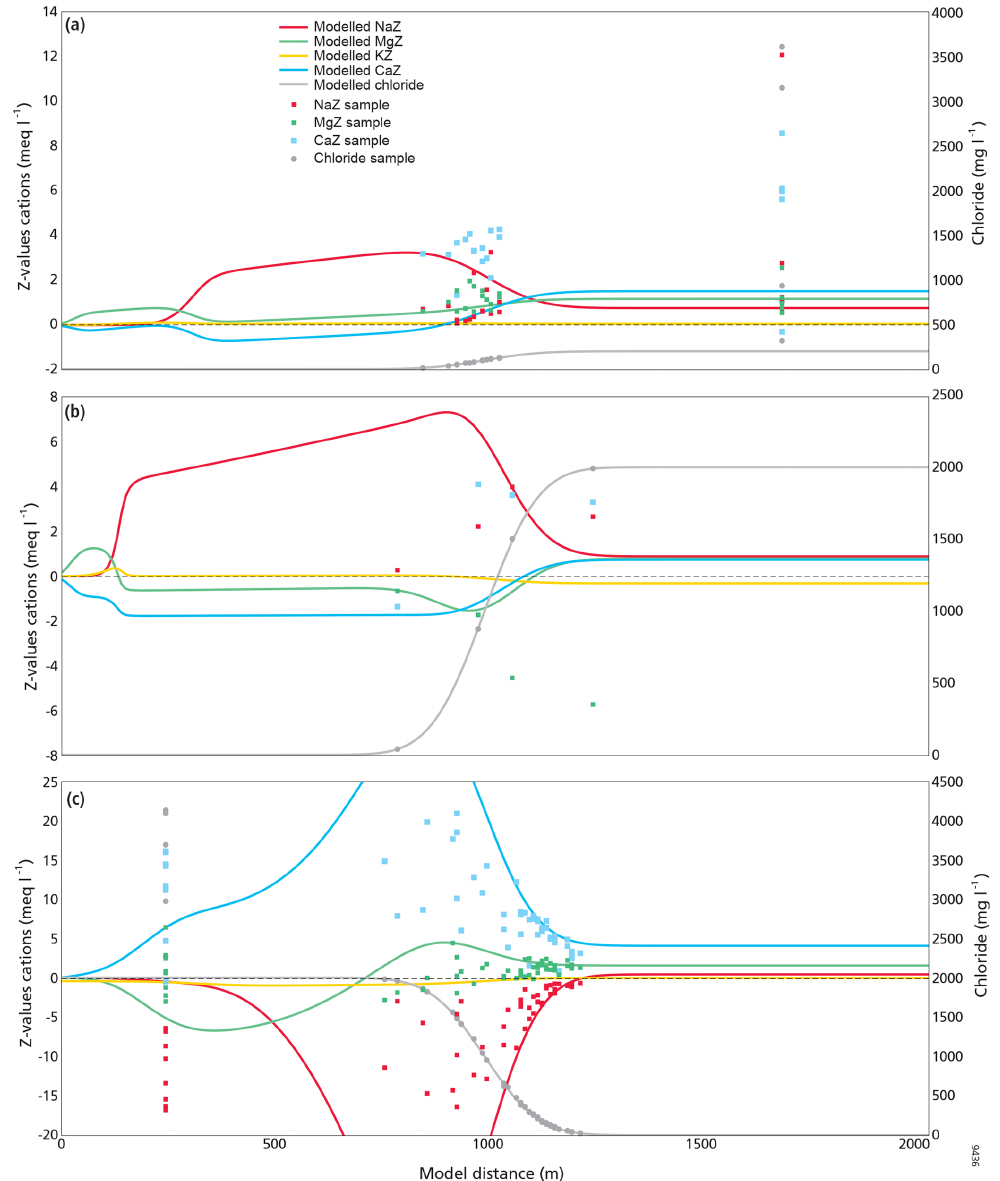
Figure 6. Results of the freshwater freshening scenario (a) , the saline water freshening scenario (b) and the salinization scenario (c) , together with the samples that match each scenario according to the Z values of their cations. The X location of the samples is determined by the chloride concentration matching the values of the chloride in the scenario. Samples with a chloride concentration exceeding the chloride values in the scenario are plotted at x = 250 or x =